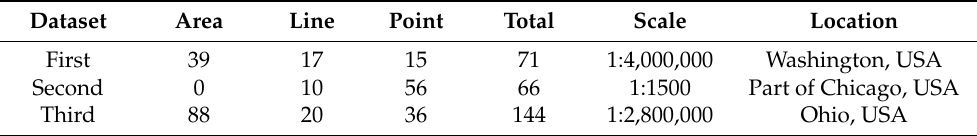
Table 1. Three real-world datasets with multiple geographical